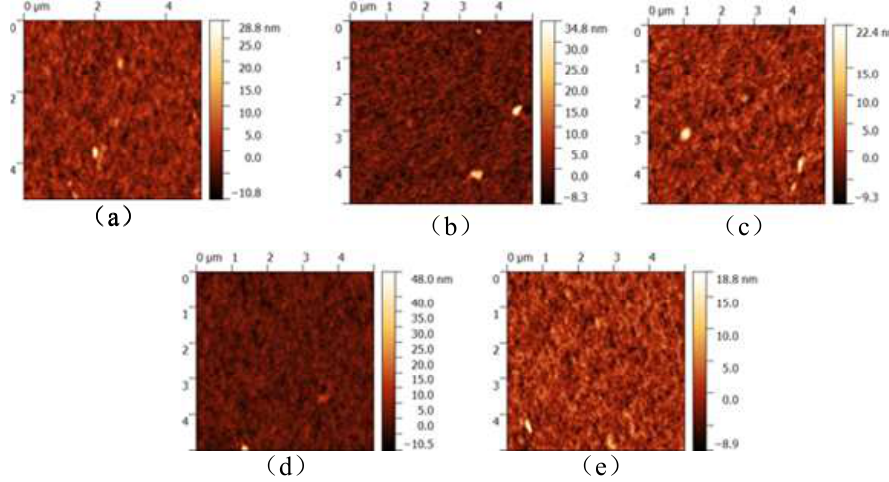
Figure 6. AFM images of PEDOT:PSS films with different exposure times of ( a ) 0 min; ( b ) 15 min; ( c ) 30 min; ( d ) 45 min; and ( e ) 60